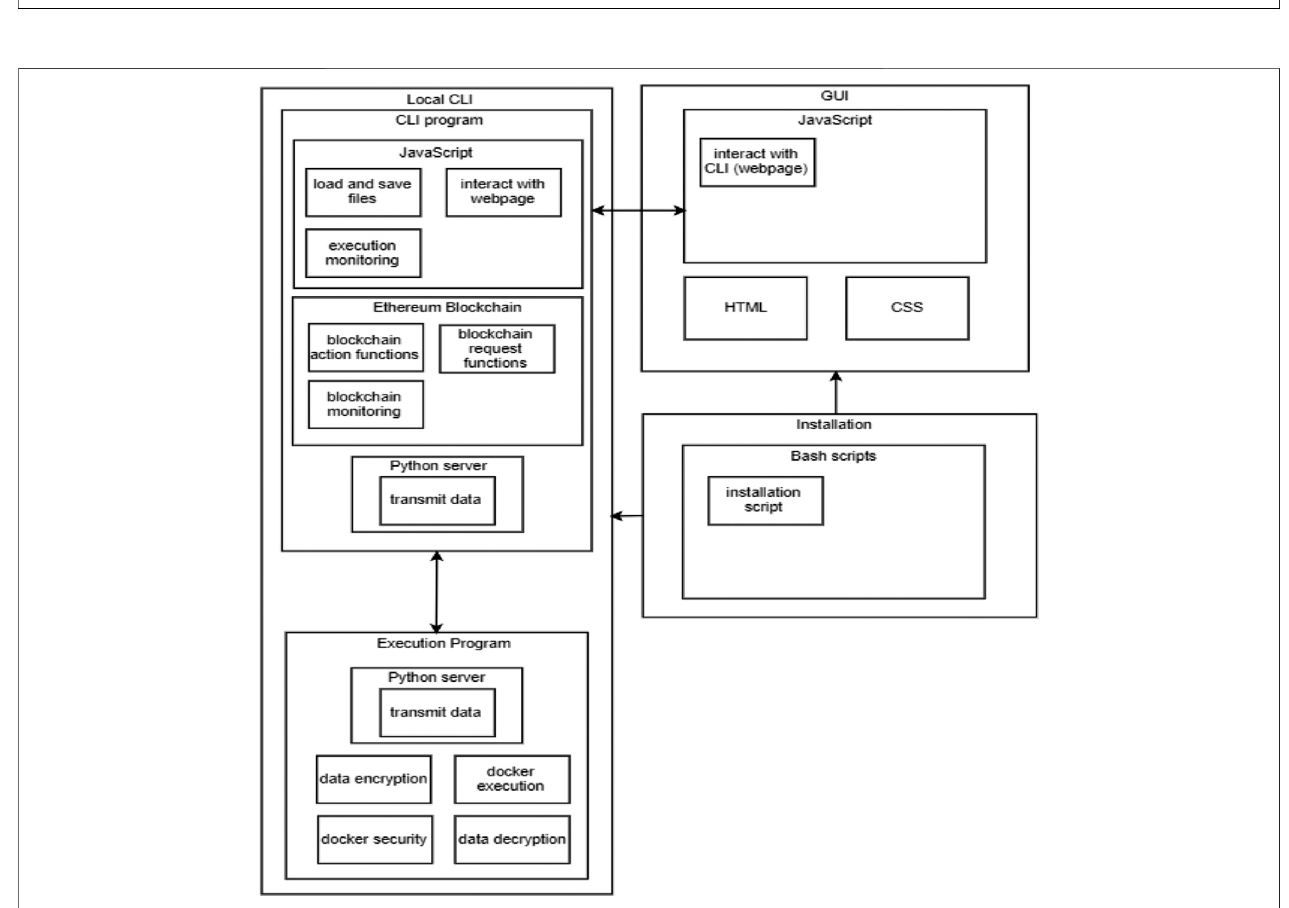
FIGURE 3 | Subsystem diagram of application.